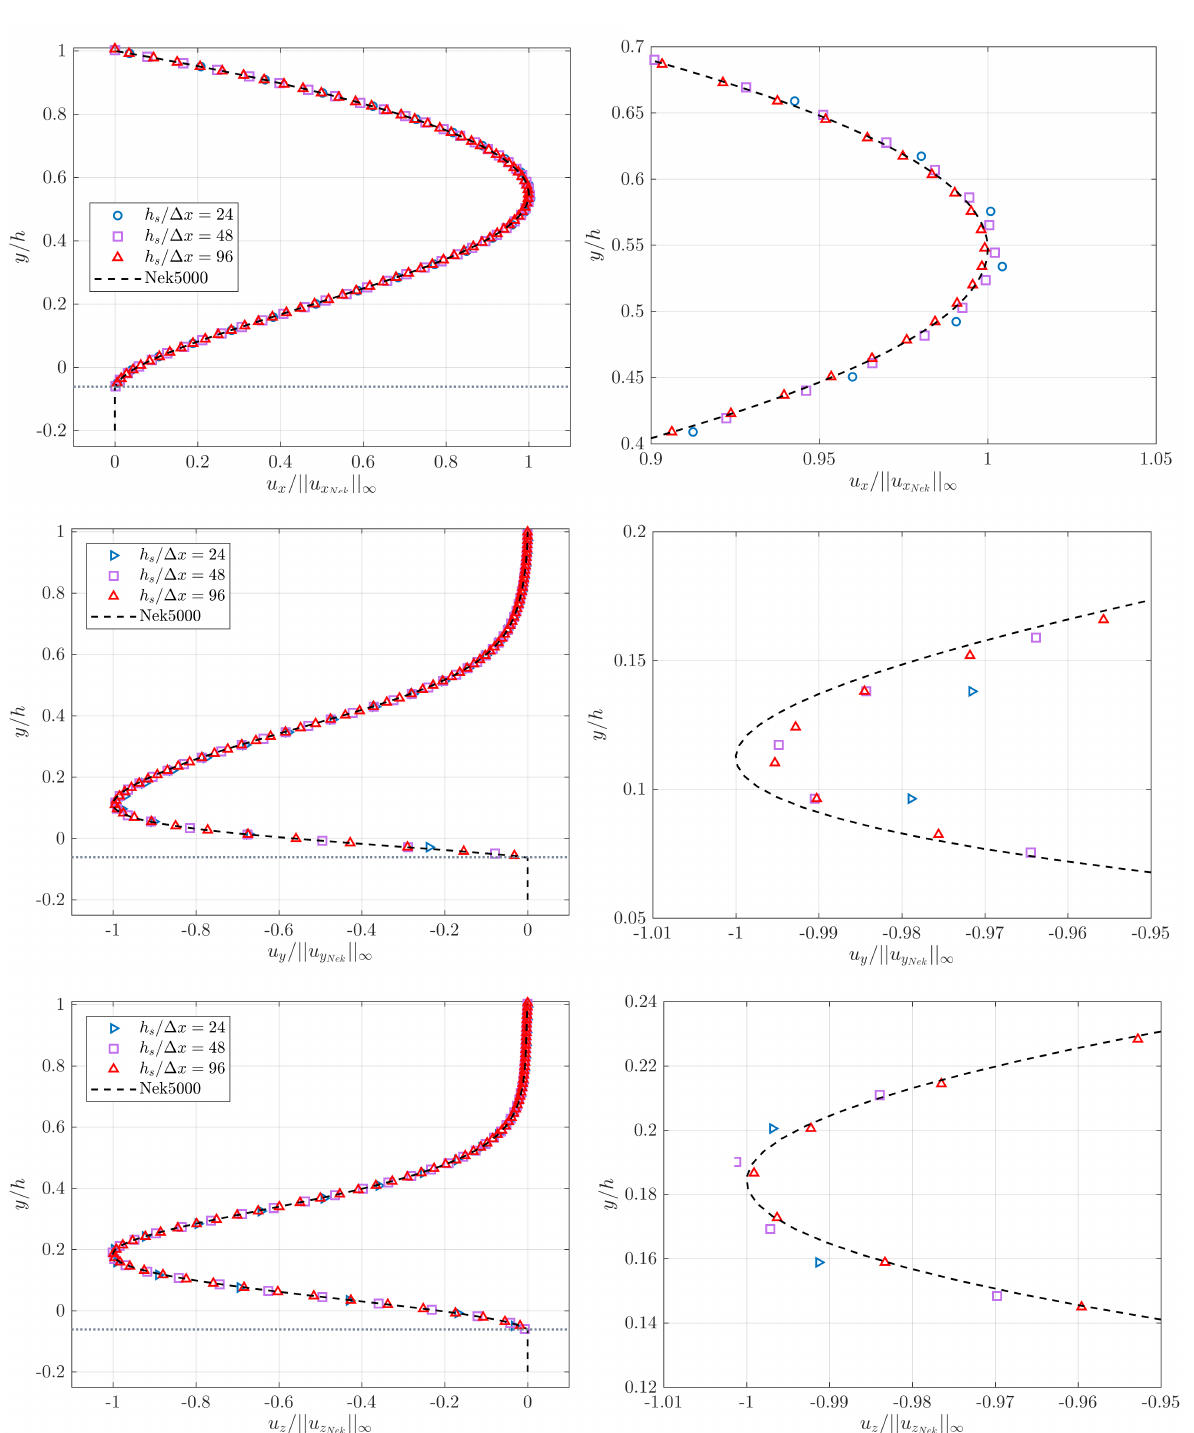
Figure 18. Profiles of u x , u y and u z for h / ∆ x = 24,48,96 along the wall-normal direction, profile set at ( x 3 , z 3 )